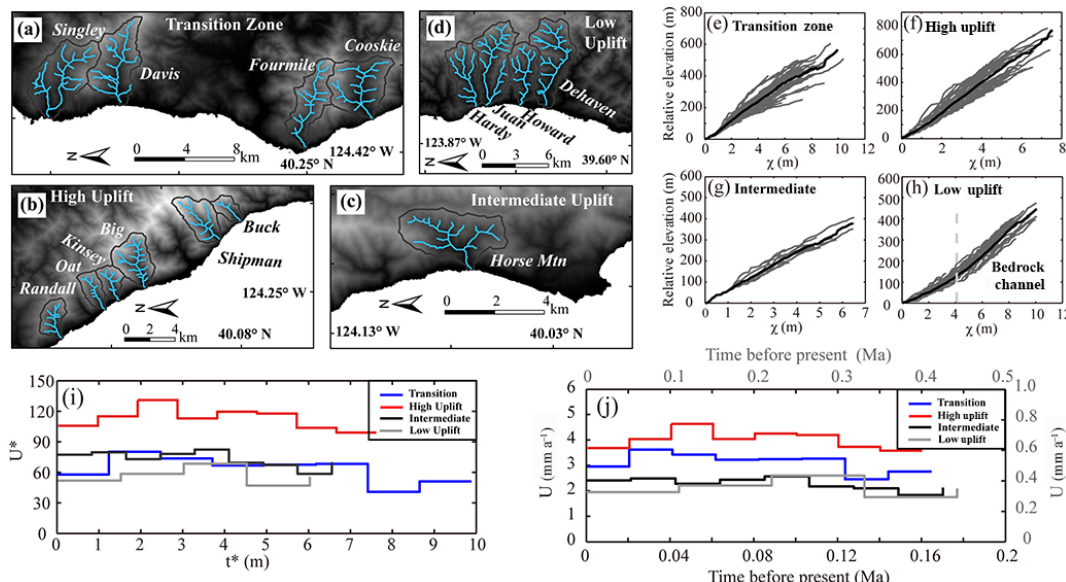
Figure 15. Uplift histories inferred from the stream profiles. (a–d) The map of streams in the four zones: the north transition zone (a) , King Range high-uplift zone (b) , intermediate-uplift zone (c) , and low-uplift zone (d) . (e–h) The χ − z plots of the streams within each zone ( A 0 = 1m 2 ). The black line indicates an average result. (i) Scaled U ∗ as a function of scaled time t ∗ . (j) Inferred relative uplift rate as a function of time before the present. The bottom-left black axes show the results of the north transition, high-uplift and intermediate-uplift zones. The top-right gray axes show the result of low-uplift zone.